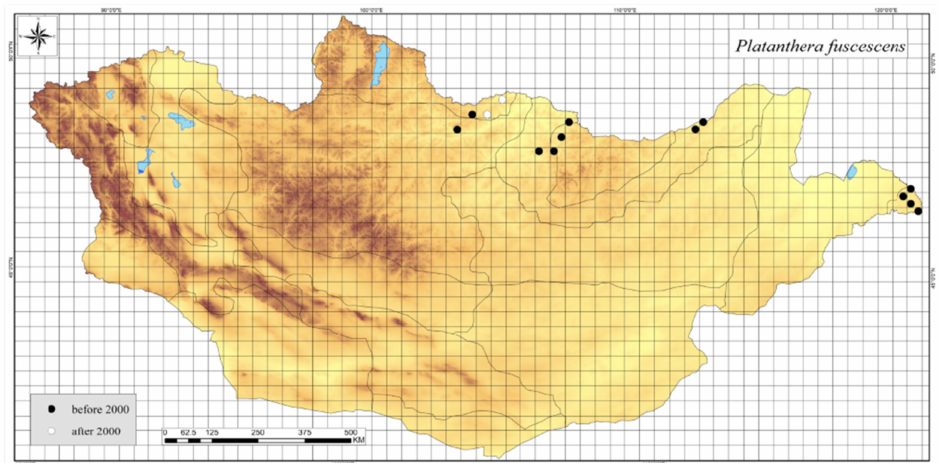
Figure A23. Distribution map of Platanthera fuscescens in